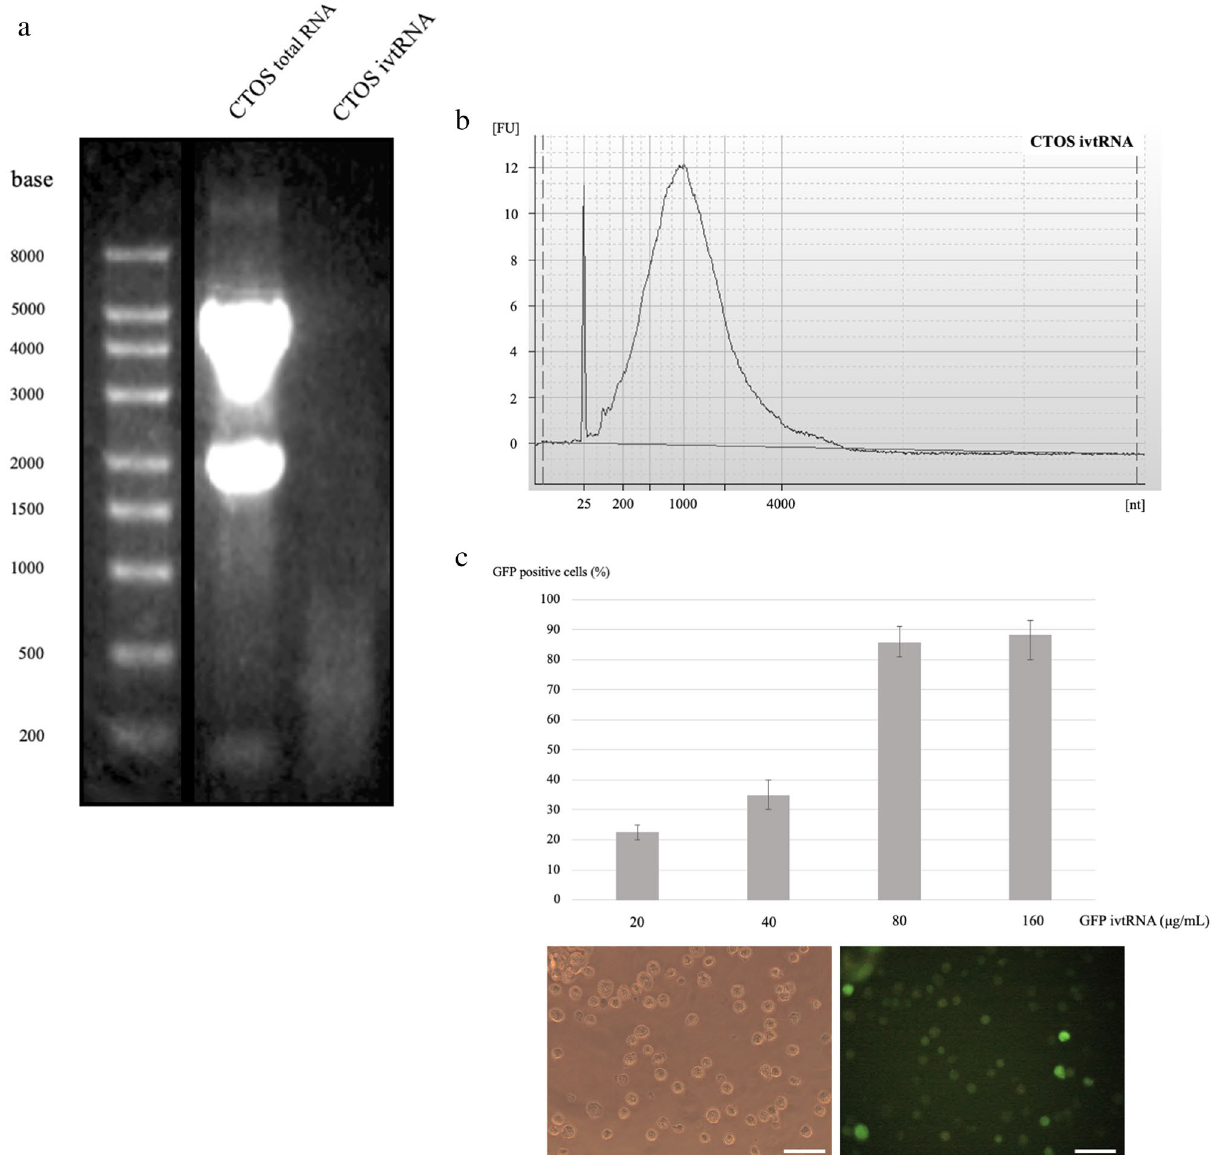
Figure 3. Analysis and functional evaluation of ivtRNA. ( a ) CTOSs total RNA and amplified CTOSs ivtRNA were subjected to agarose/formaldehyde gel electrophoresis and stained with ethidium bromide. Full-length blots/gels are presented in Supplementary information 5. ( b ) Microelectrophoresis curves from ivtRNA (Agilent 2100 bioanalyzer RNA6000 Pico Kit). ( c ) GFP expression rates at 24 h after electroporation of GFP ivtRNA. Experiments were performed in triplicate per condition. Phase contrast image (left) and fluorescent image (right) after 24 h with 80 μg/ ml GFP ivtRNA. Scale bars = 40